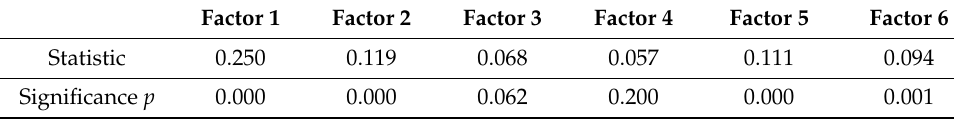
Table 10. Tests of Normality Kolmogorov-Smirnov for all